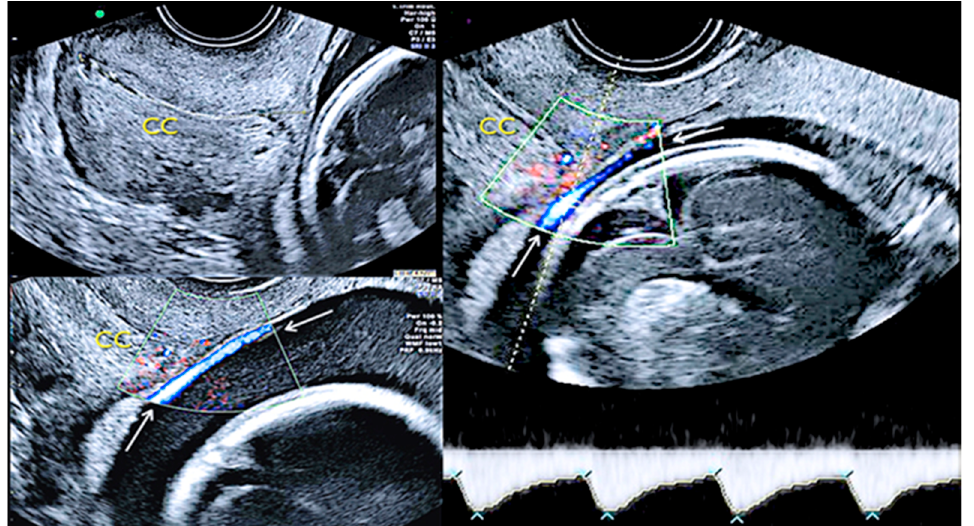
Figure 17. Pregnancy at 24 weeks’ gestation. Two-dimensional ultrasound, color and pulse wave (PW) spectral Doppler ultrasound allowed the detection of an arterial vessel close to the internal cervical os (vasa praevia Type III, white arrows)(Legend: CC: cervical canal).